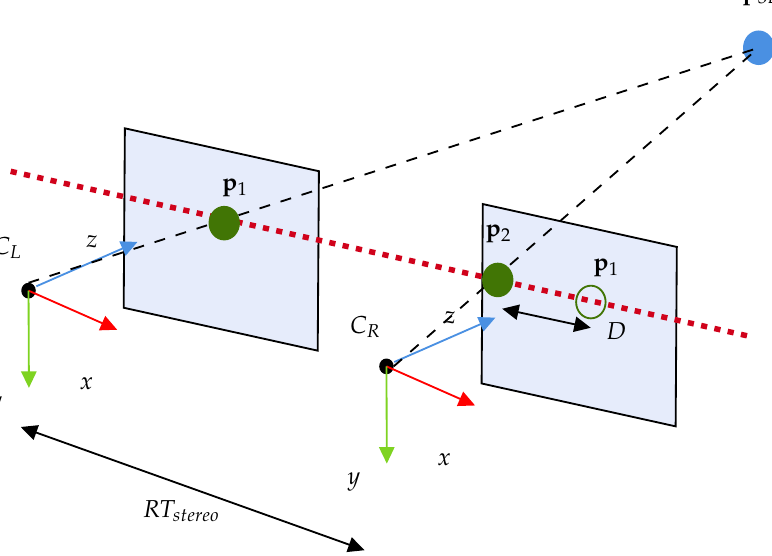
Figure 1. Stereo vision observation model. A 3D point is reprojected in both cameras. The extrinsic calibration of the stereo pair is defined by the rototranslation RT stereo